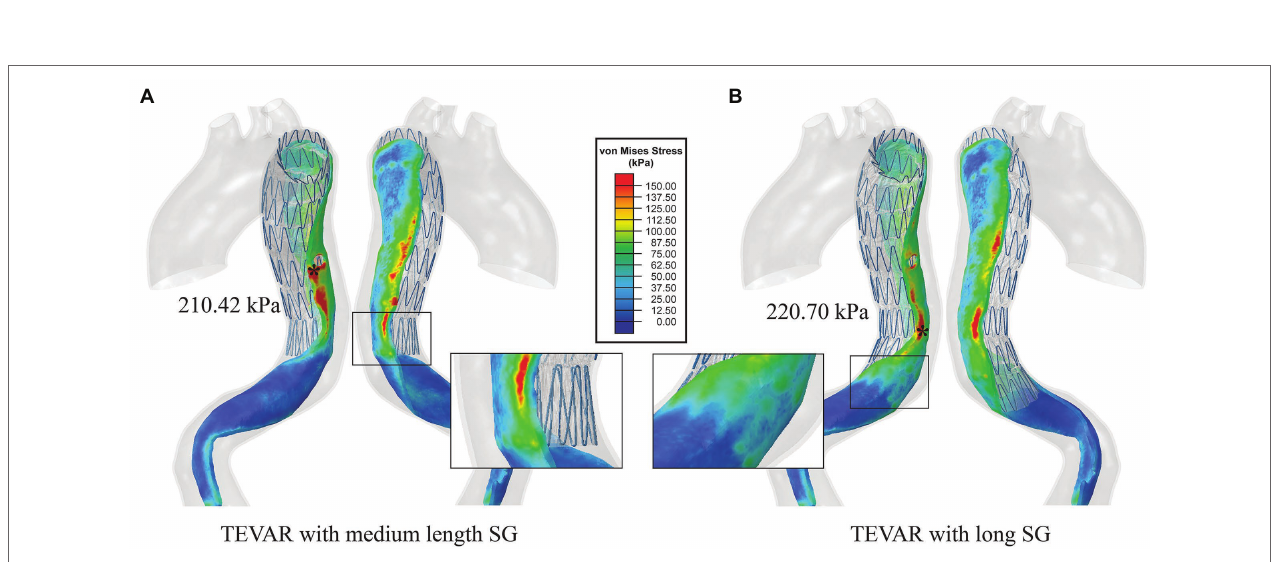
FIGURE 6 | Distribution of von Mises stress on the aortic wall. High stress of 283.26 kPa was found at the location where a proximal tear was found at 12-month